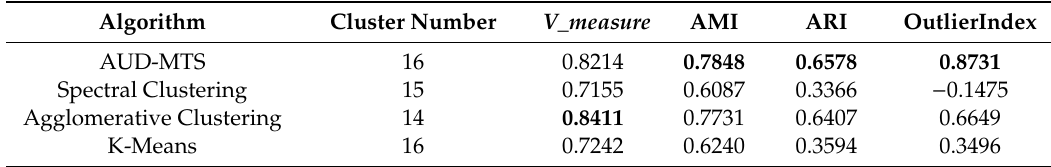
Table 3. Performance of di ff erent clustering algorithms referring to defined indicators.